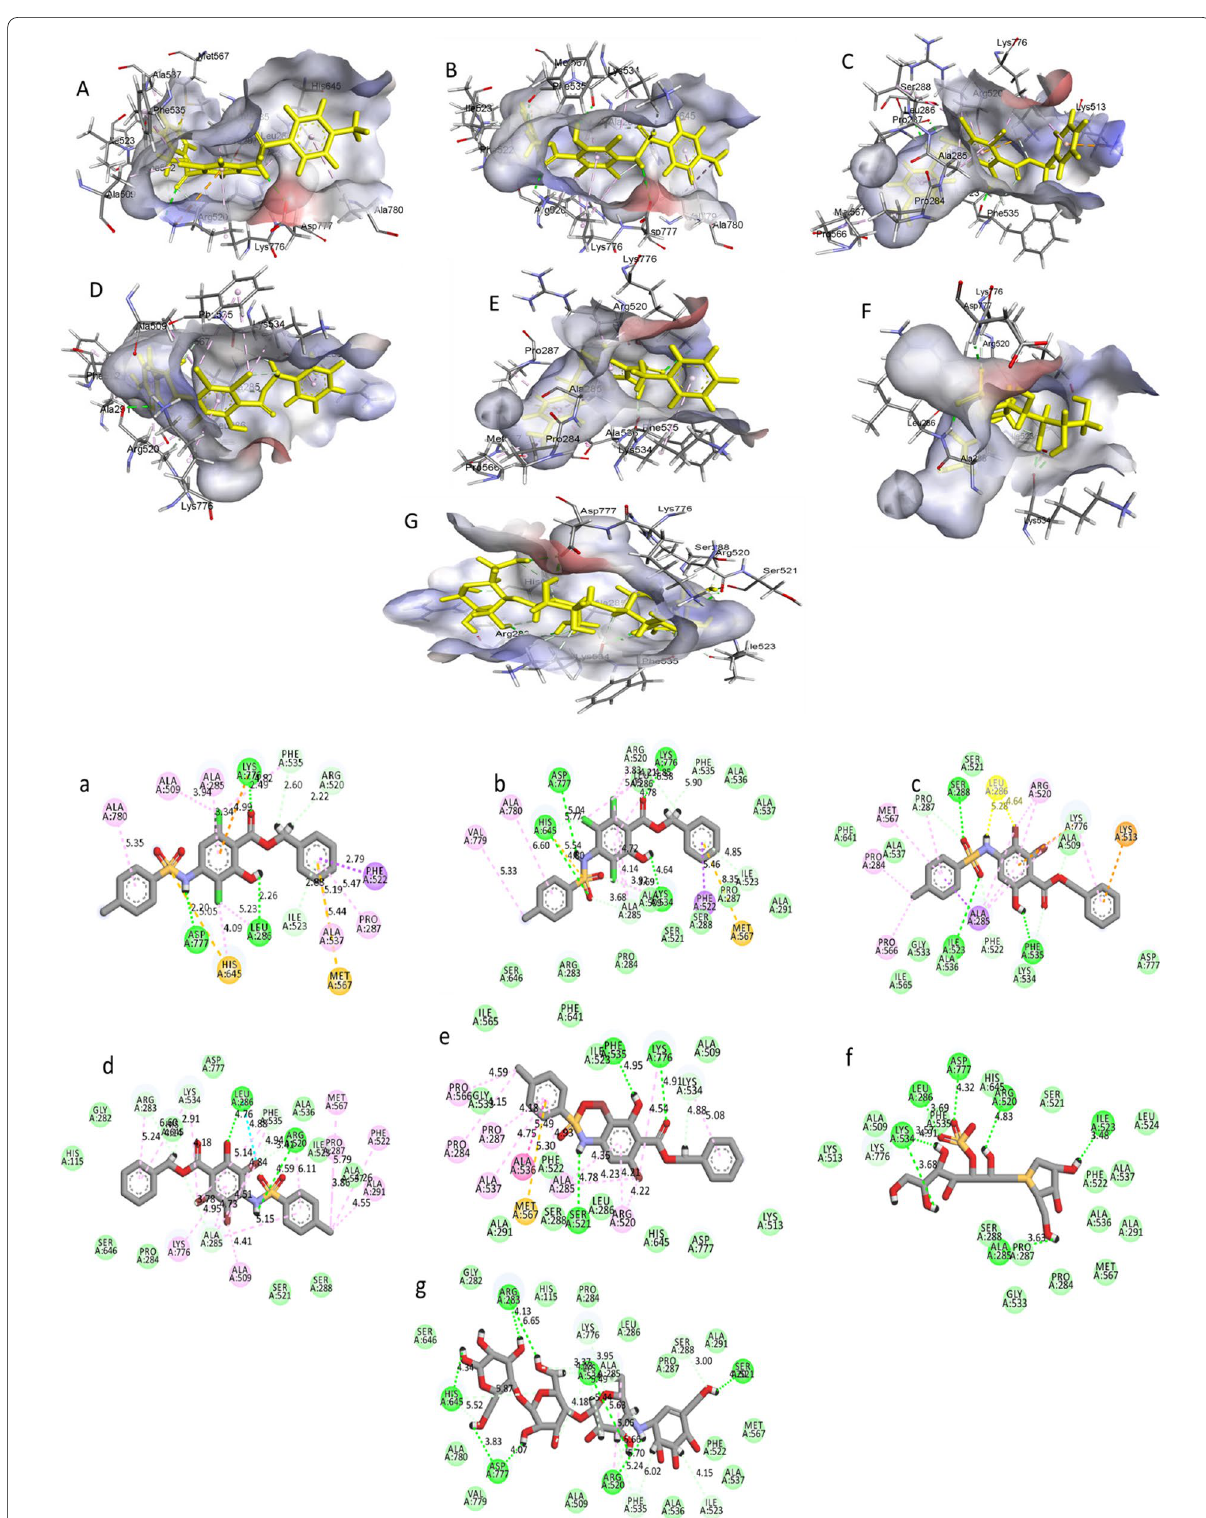
Fig. 5 3D and 2D Interactions of Analogue A1 ( A and a ), Analogue A2 ( B and b ), Analogue A3 ( C and c ), Analogue A4 ( D and d ), Analogue A5 ( E and e ), kotalanol ( F and f ) and acarbose ( G and g ) with α -glucosidase